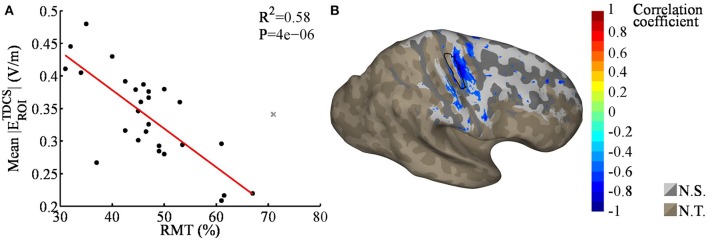
(A) Regression plot of the mean transcranial direct current stimulation electric fields (TDCS EFs) within the region of interest [ROI; black outlined area in (B)], as a function of the resting motor threshold (RMT); the gray cross marks the outlier that was omitted from the analysis. The RMT was found to correlate significantly with the TDCS EFs. (B) Nodewise correlation between the RMT and individual TDCS EFs; the significant correlation coefficients are shown in color, the non-significant coefficients in gray (N.S.), and the unstudied areas (average TDCS EF lower than 50% of the maximum) in brown (N.T.). The shading in the gray/brown areas represents the gyral structure of the brain (dark = sulci, light = gyri).